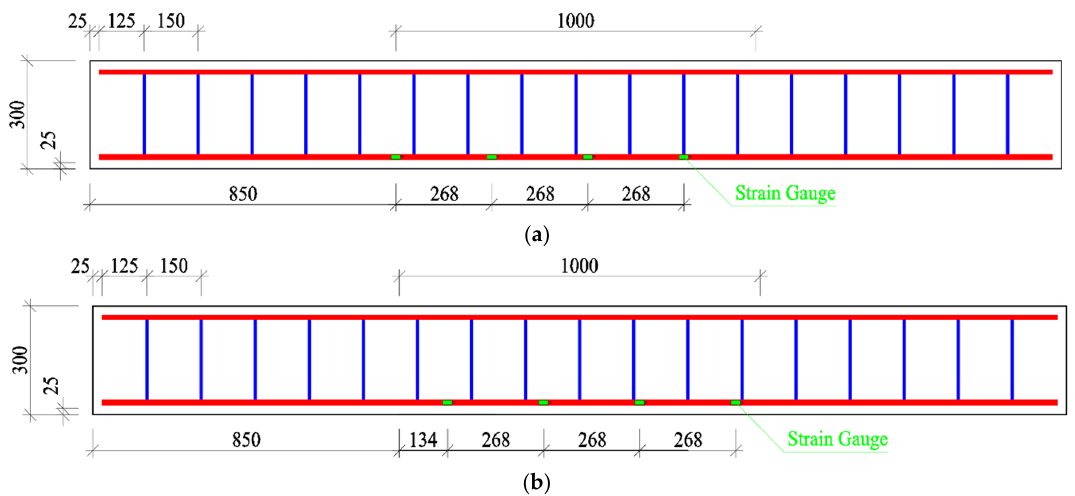
Figure 2. Arrangement of strain gauges on: ( a ) one of the longitudinal tensile rebars; ( b ) another longitudinal tensile rebar.